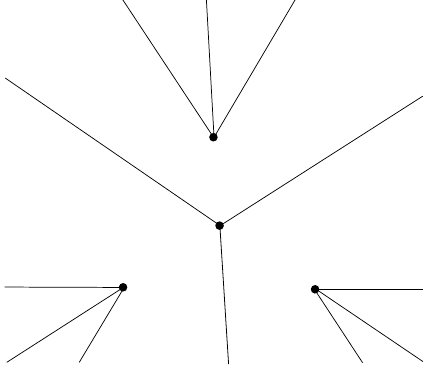
Fig. 1: The order partition of a set of four